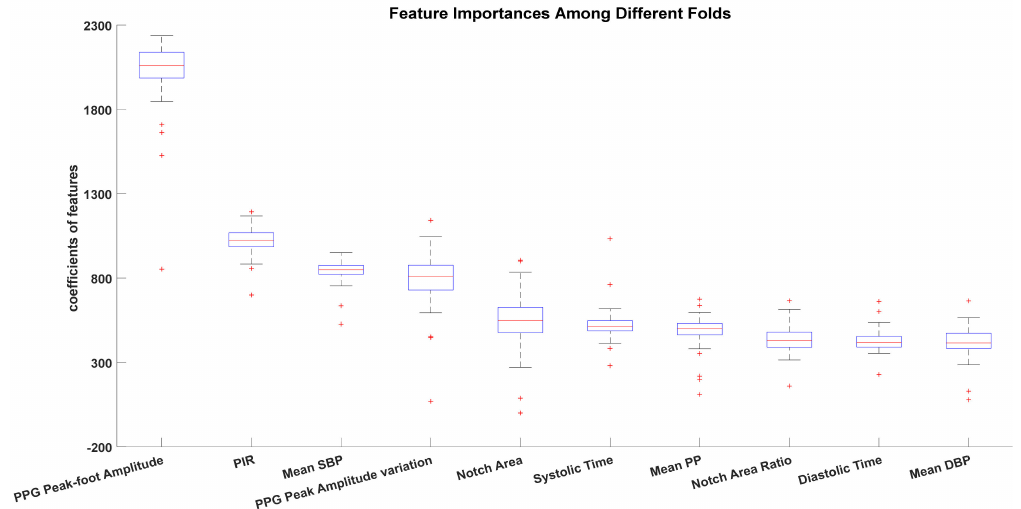
Figure 5. Features’ importance variation among di ff erent folds of the first 10 importance features of the LASSO-derived person-specific model using ABP&PPG